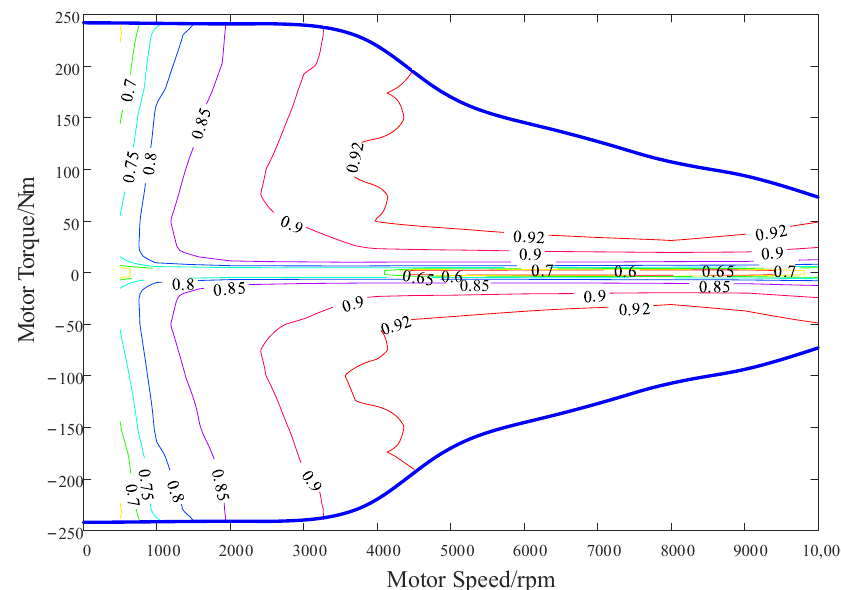
Figure 1. E ffi ciency map of the electrical machine. Figure 1. Efficiency map of the electrical